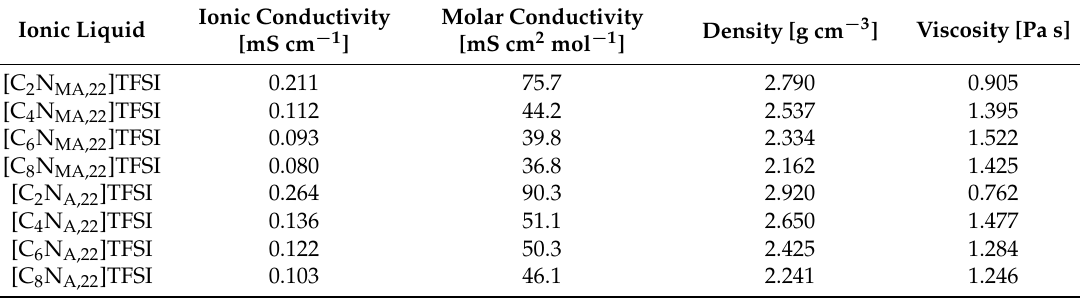
Figure 5. Ionic conductivity values at various temperatures for methacrylate ILs ( a ) and acrylate ILs ( b ). Table 5. Experimentally measured values of ionic conductivity ( κ ), density ( d ), viscosity ( η ) and calculated molar conductivity ( Λ m ) at 25 ◦ C and at pressure p = 0.1 MPa. Standard uncertainties u for values from this work are u ( d ) = 0.001 g cm − 3 ; u ( η ) = 0.05 · η ; u ( κ ) = 0.03 · κ ; u ( p ) = 5 kPa; u ( Λ m ) = 0.06 · Λ m ; u ( T κ ) = 0.1 K; u ( T η ) = 0.1 K; u ( T d ) = 0.01 K (specified temperature during conductivity ( T κ ), density ( T d ) and viscosity ( T η ) measurement).